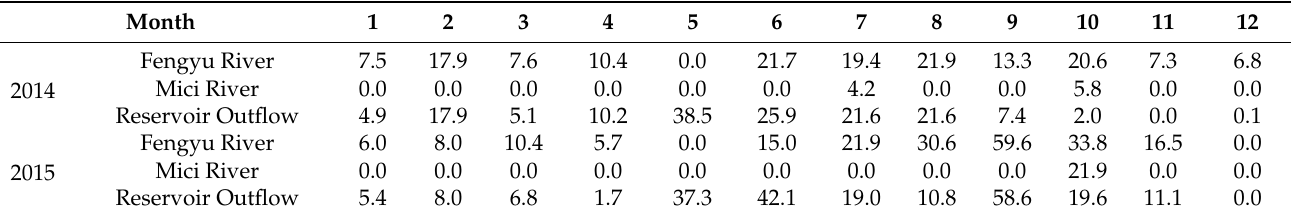
Table 4. The inflow and outflow of Cibihu Reservoir (unit 10 4 m 3 /d).